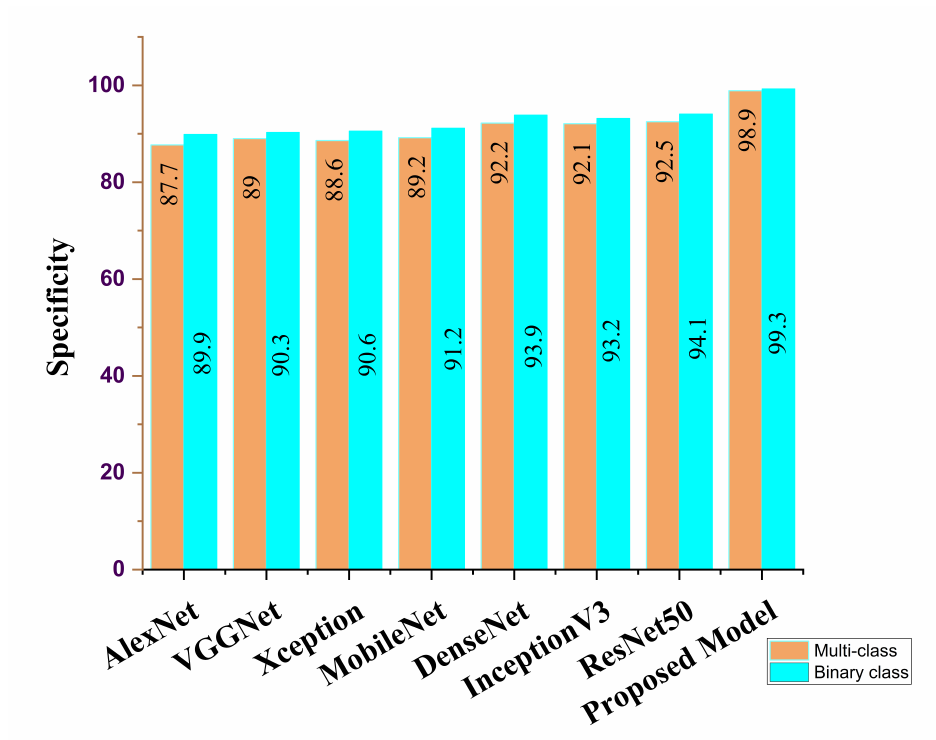
Figure 10. Our proposed MESRGAN+ and Siamese Capsule Network (Siamese-CapsNet). Table 4. Classification performance of our proposed model based on binary and multiple cate- gory